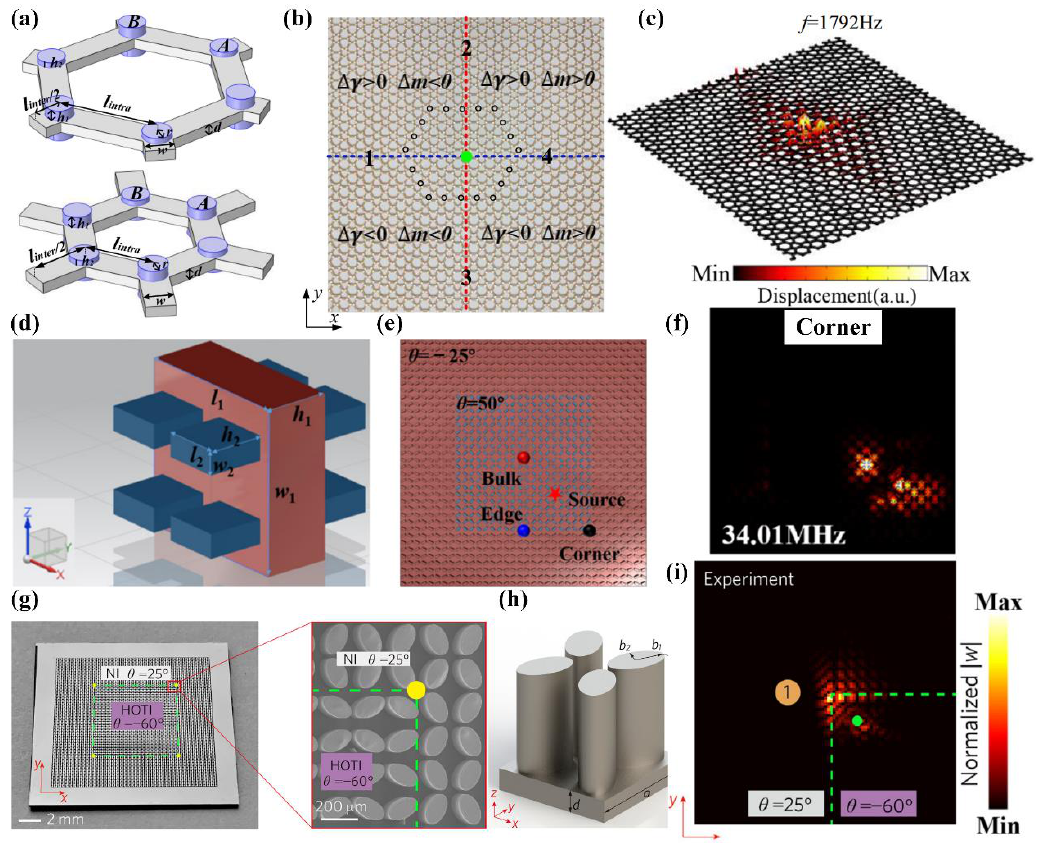
Figure 6. Other experimental realizations of C n -symmetric HOTIs. ( a ) Composite unit cells with ∆ γ = 0.164, ∆ m = 0.5 (top) and ∆ γ = − 0.2, ∆ m = − 0.5 (bottom) [109]. ( b ) The square elastic phononic crystal sample. The black circles signal the locations of defects [109]. ( c ) The corner mode at 1792 Hz [109]. ( d ) A composite unit cell consists of stainless-steel prisms(blue) and an aluminum plate(red) [110]. ( e ) The squared metamaterial formed by the two phononic crystals θ = − 25 ◦ and θ = 50 ◦ , respectively. ( f ) The corner state at 34.01 MHz [110]. ( g ) The photo of the fabricated sample chip [111]. ( h ) The unit cell of the square lattice photonic crystal [111]. ( i ) One corner mode in the experiment system [111].